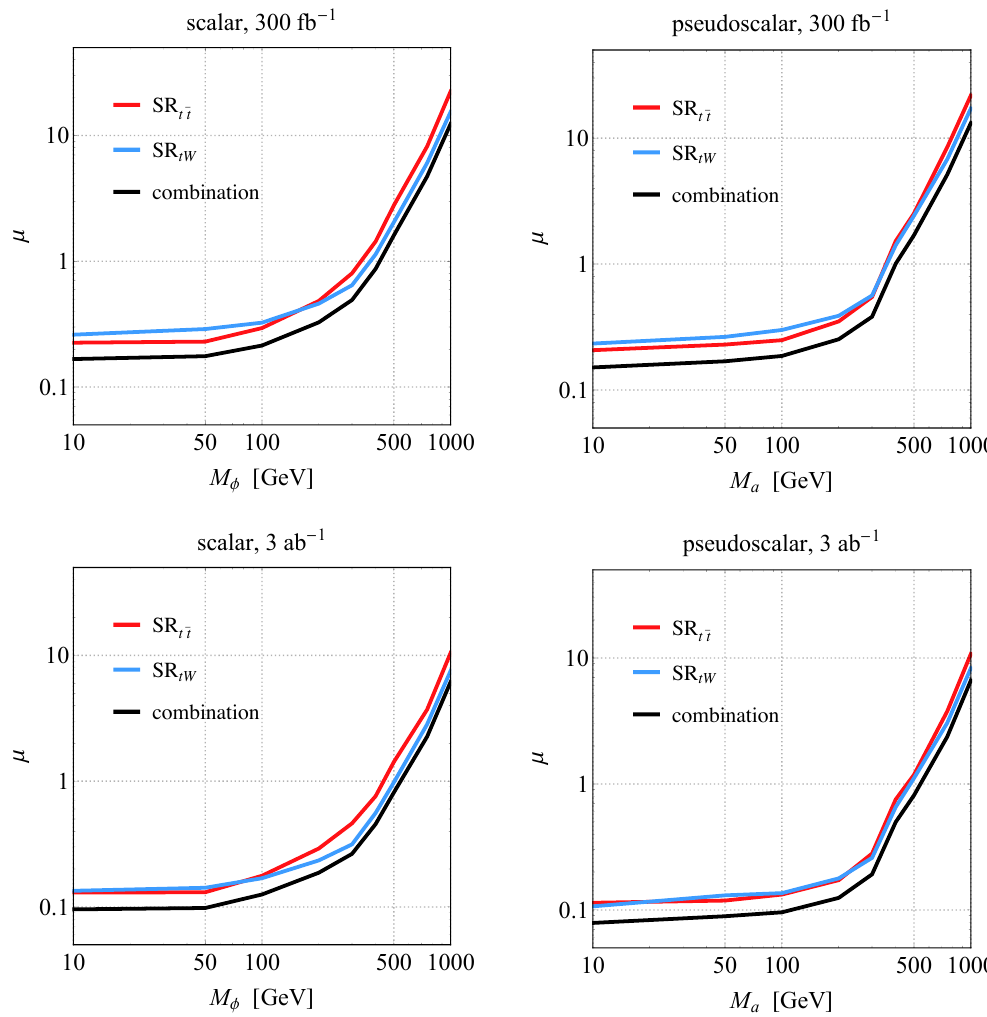
Figure 8 . Value of the signal strength (cid:22) that can be excluded at 95% CL as a function of the mass for scalar (left) and pseudoscalar (right) mediators. The reach for 300 fb (cid:0) 1 (upper row) and 3 ab (cid:0) 1 (lower row) of 14 TeV LHC data is shown and the parameter choices m (cid:31) = 1 GeV and g (cid:31) = g t = 1 have been